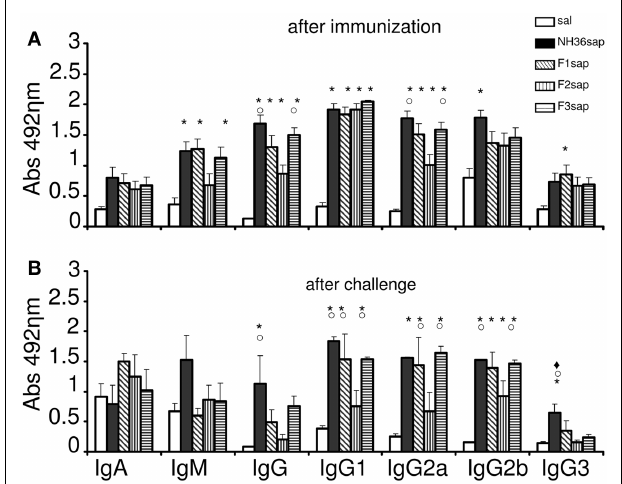
FIGURE 1 | Development of NH36-specific humoral immune response. Bars represent the mean ± SE of the absorbance values of anti-NH36 antibodies from 1/100 diluted serum of three independent experiments after immunization ( n = 3 mice per treatment in each experiment) (A) and two independent experiments after challenge ( n = 7 mice per treatment in each experiment) (B) . * p < 0.05 from the saline control; p < 0.05 different from the F2sap vaccine; p < 0.05 different from